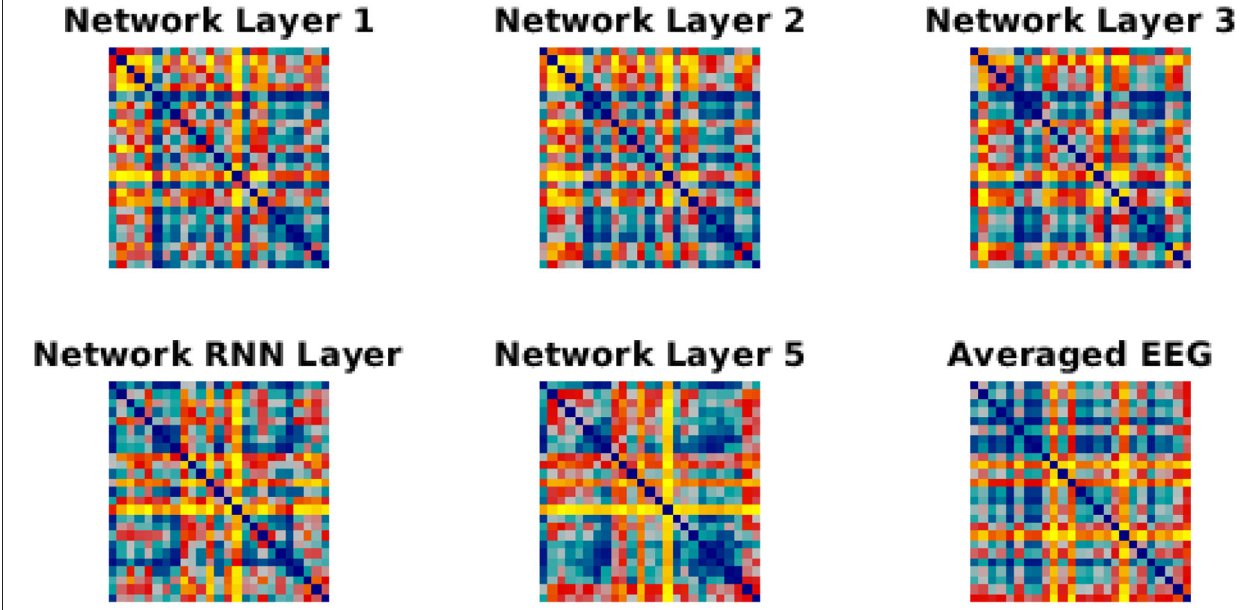
FIGURE 5 | RDMs for network layer and EEG. Each similarity matrix was separately rank-transformed and scaled into the range [0, 1]. The EEG RDM is averaged across participants.